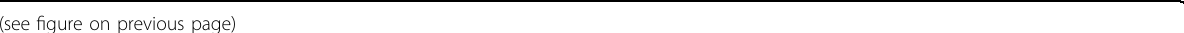
Fig. 7 The expression of cross-linked HA in cancer tissues from mouse tumor model. A Double staining of HA and vimentin in cancer tissues from different groups. White arrowheads refer to the co-localization of HA (red) and fi broblasts (green, vimentin + ). B Double staining of HA and TSG6 in cancer tissues. White arrows indicate the co-localization of HA (red) and TSG6 (green). C Double staining of HA and I- α -I HC1 in cancer tissues. White arrowheads indicate the co-localization of HA (red) and I- α -I HC1 (green). D Double staining of HA and I- α -I HC2 in cancer tissues. White arrows indicate the co-localization of HA (red) and I- α -I HC2 (green). E The intensity ratio of HA co-localized with I- α -I HCs to total HA was used to determine the levels of HA-HC complexes. Error bars represent mean ± SD values. Statistical analysis was performed using Student ’ s t test. *** p < 0.001 (vs + NFb Control ), ### p < 0.001 (vs + CAF Control ). F Graphic depicting a model for the role of HA crossing-linking in CAF-dependent breast cancer